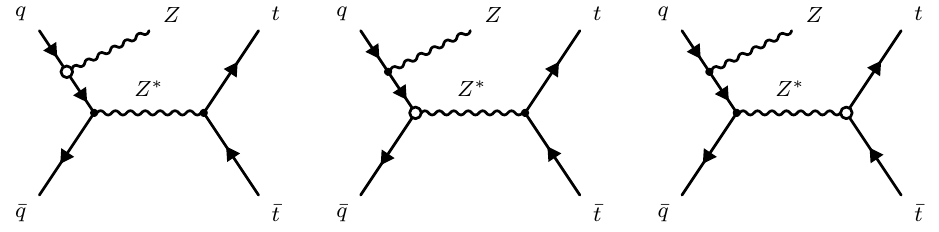
Figure 3 . Examples of Feynman diagrams for electroweak contributions to t ¯ tZ production in SMEFT. The circles indicate operator insertions in the